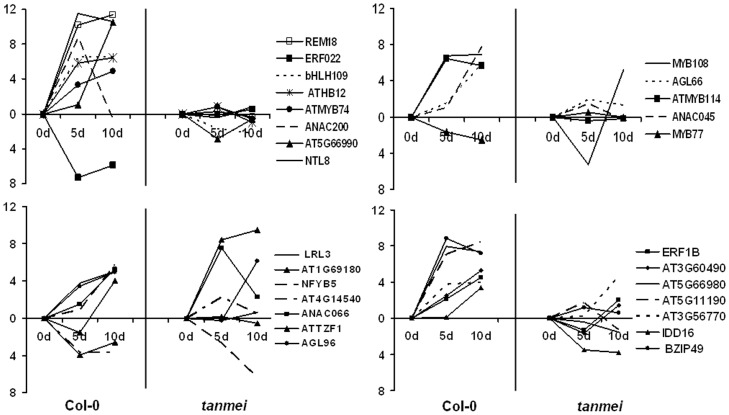
Expression profiles of SE-associated genes.The graph shows contrasting expression levels of TFs in embryogenic (Col-0) and non-embryogenic (tanmei) cultures. The relative transcripts levels of the genes are shown as ddCt.